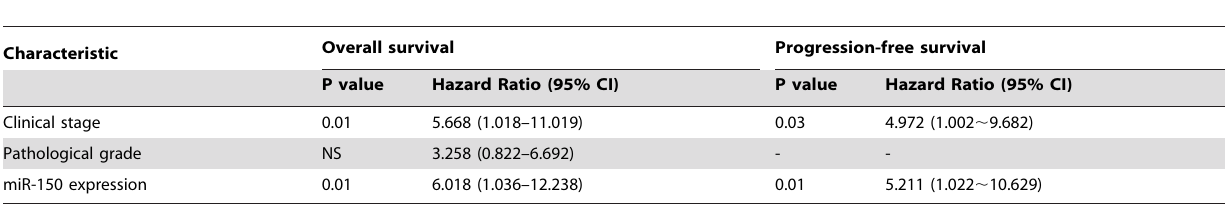
Table 3. Multivariate analysis: factors predicting overall and progression-free